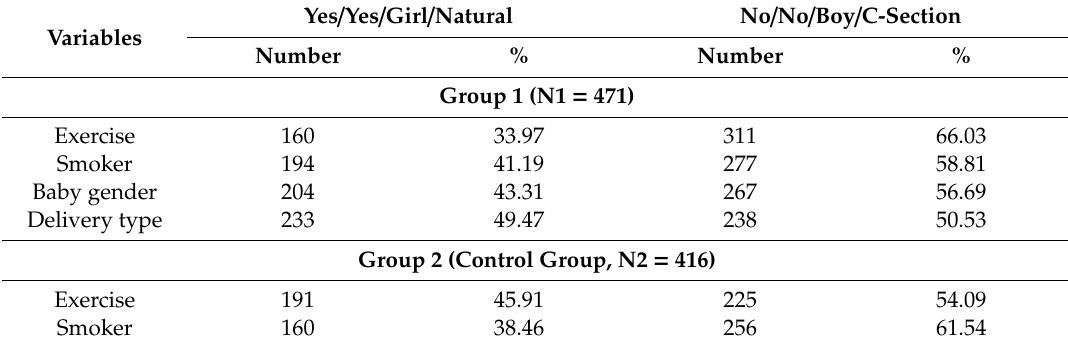
Table 6. The frequency table according on the qualitative characteristics of both groups.